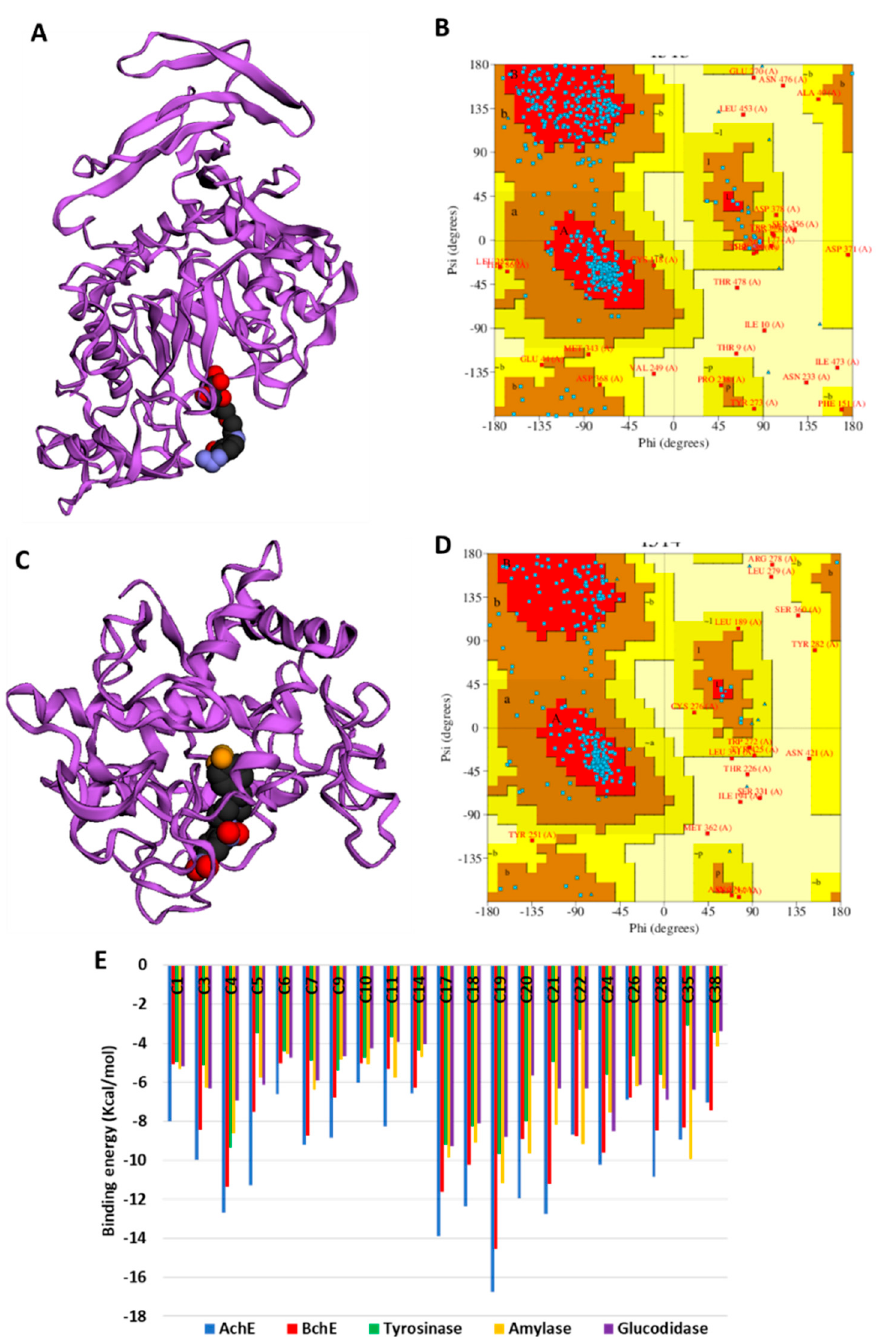
Figure 3. ( A ) Homology modeled structures of glucosidase, and ( B ) its Ramachandran plot showing the energetically allowed regions. ( C ) Homology modeled structures of tyrosinase and ( D ) its Ramachandran plot showing the energetically allowed regions. Binding energy (docking score) values of the top bioactive compounds from two Cassia and two Senna species. The compounds are abbreviated based on their serial number in Table 2.